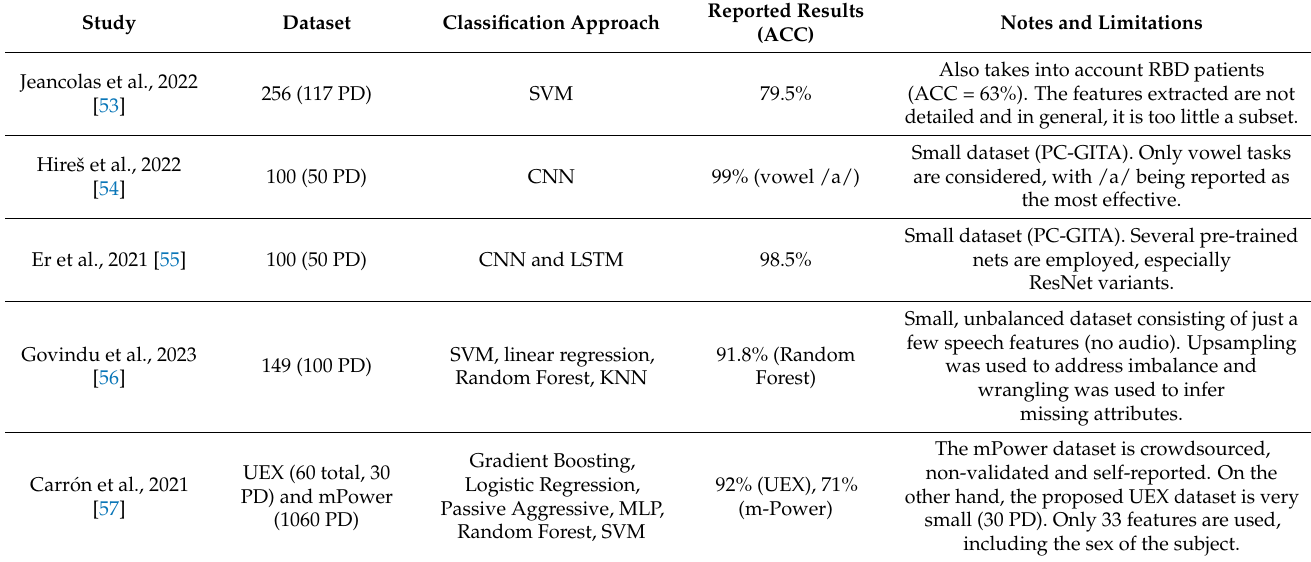
Table 1. Brief literature overview (more in the literature review by Amato et al. [52]). All references to datasets and methodologies can be found in the corresponding paper. Accuracies are averaged if not